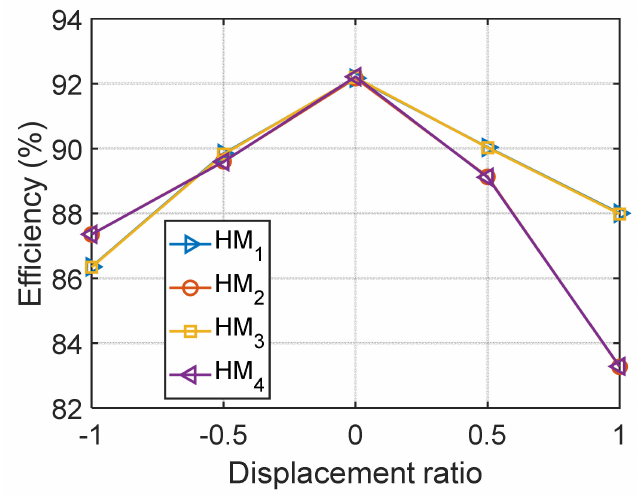
Figure 6. Mean efficiency of different displacement ratios at the stages.